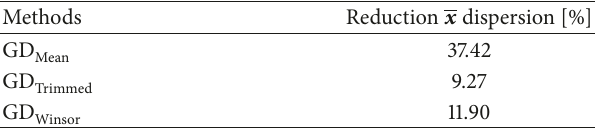
Table 65: G-h with 1000